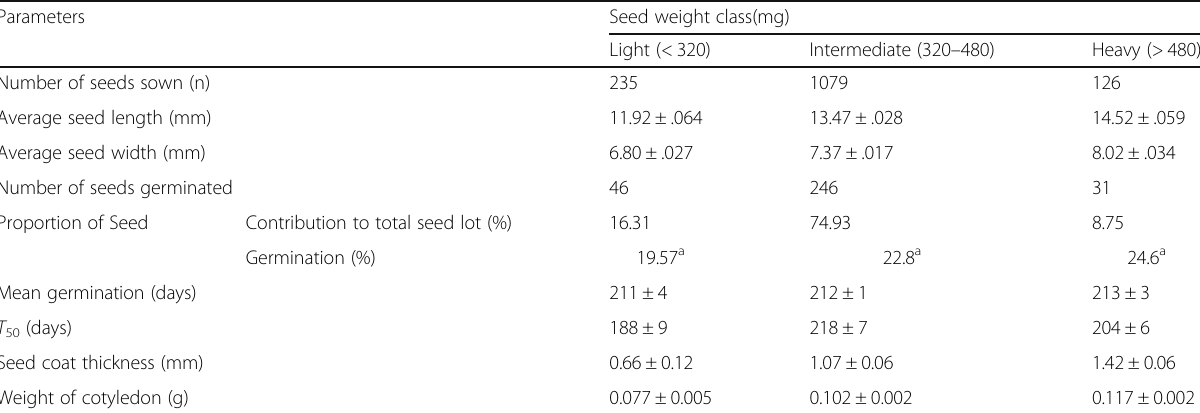
Table 3 Germination characteristics of E. prunifolius seeds Parameters